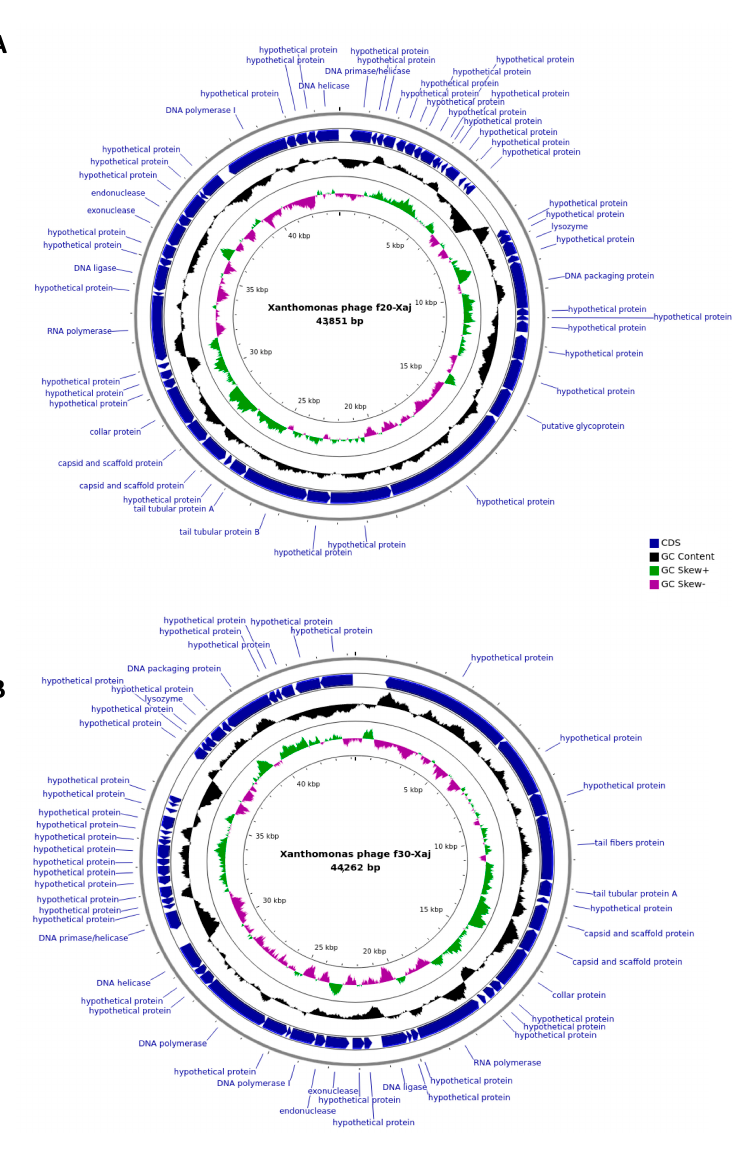
Figure 4. Map of genome organization of f 20-Xaj ( A ) and f 30-Xaj ( B ) bacteriophages using the BRIG platform and the CGView program. The ORFs are shown in blue arrows. The GC content is indicated by the black ring.